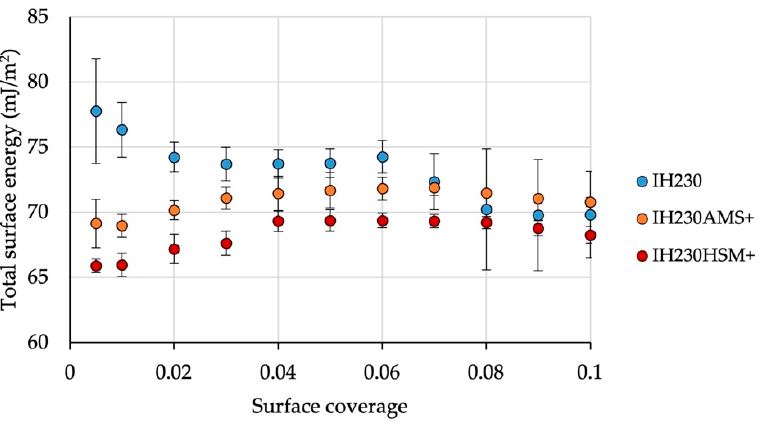
Figure 8. Total surface energy of the raw material in comparison to processed powders with the additive. n = 3, error bars show SD.